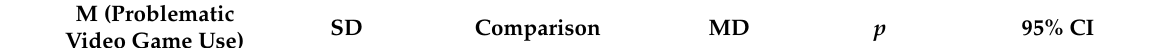
Table 1. Problematic video game use means and comparison of means by SDQ internalizing, exter- nalizing and prosocial behaviour